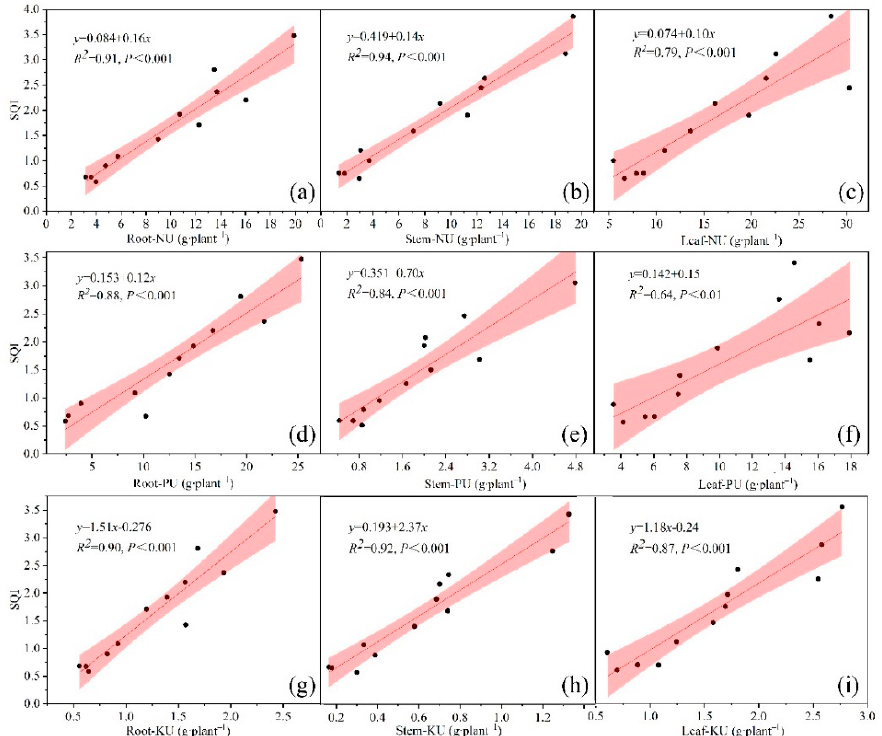
Figure 7. Correlation between SQI and nutrient uptake in the leaf, stem, and root of C. henryi seedlings. NU: N uptake; PU: P uptake; KU: K uptake. Figures represent correlation between SQI and root N uptake ( a ); stem N uptake ( b ); leaf N uptake ( c ); root P uptake ( d ); stem P uptake ( e ); leaf P uptake ( f ); root K uptake ( g ); stem K uptake ( h ); and leaf K uptake ( i ).